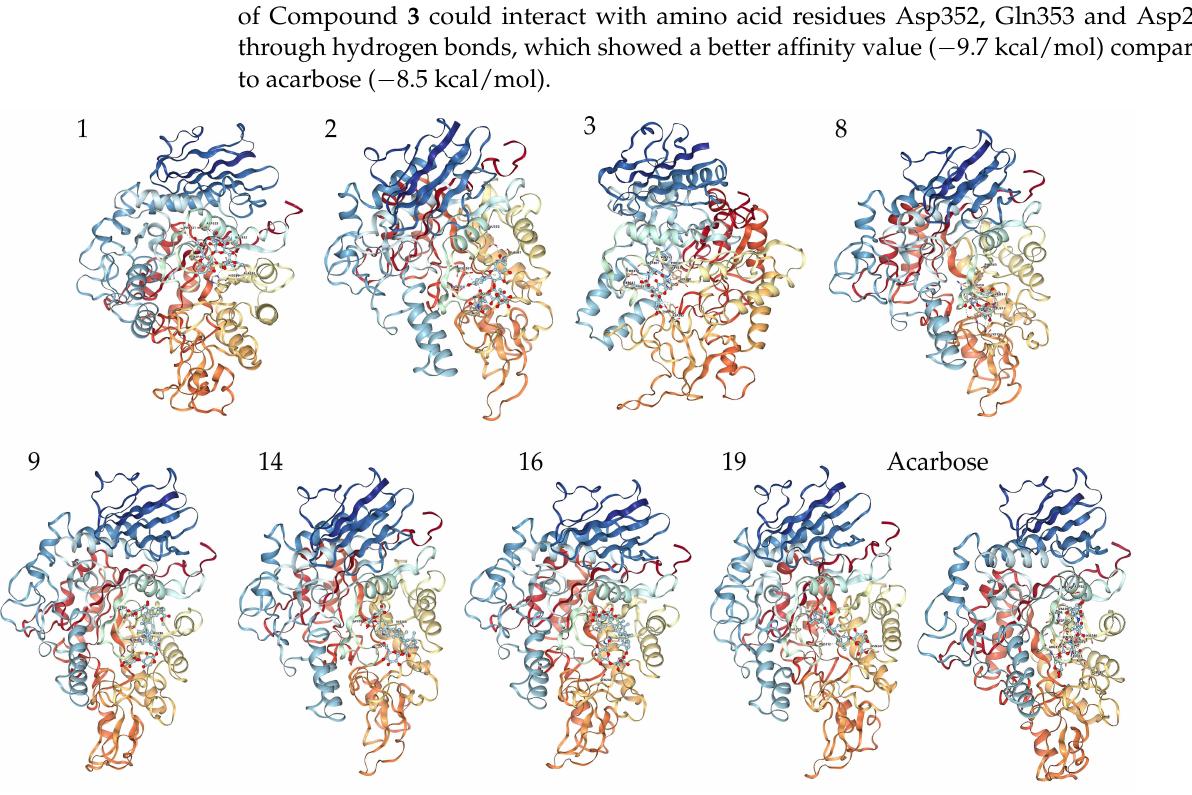
Figure 7. Conformations of the compounds (Table 5) interacting with amino acid residues at the active site of α -glucosidase. Compounds 1, 2, 3, 8 are flavonoids; Compounds 9, 14, 16, 19 are